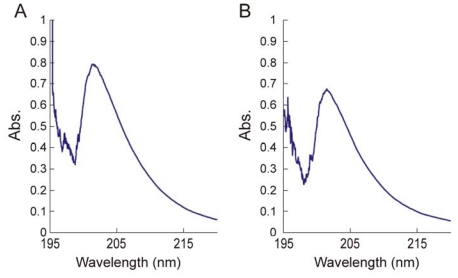
UV spectra: (a) a mixture of N-acetyl-glucosamine and glucosamine hydrochloride in 0.1 M hydrochloric acid solution; (b) chitosan in 0.1 M hydrochloric acid solution. Reprinted from Carbohydrate Research 341, 2006, Liu, D., Wei, Y., Yao, P., Jiang, L., Determination of the degree of acetylation of chitosan by UV spectrometry using dual standards, 782–785, Copyright (2010), with permission from Elsevier [180].